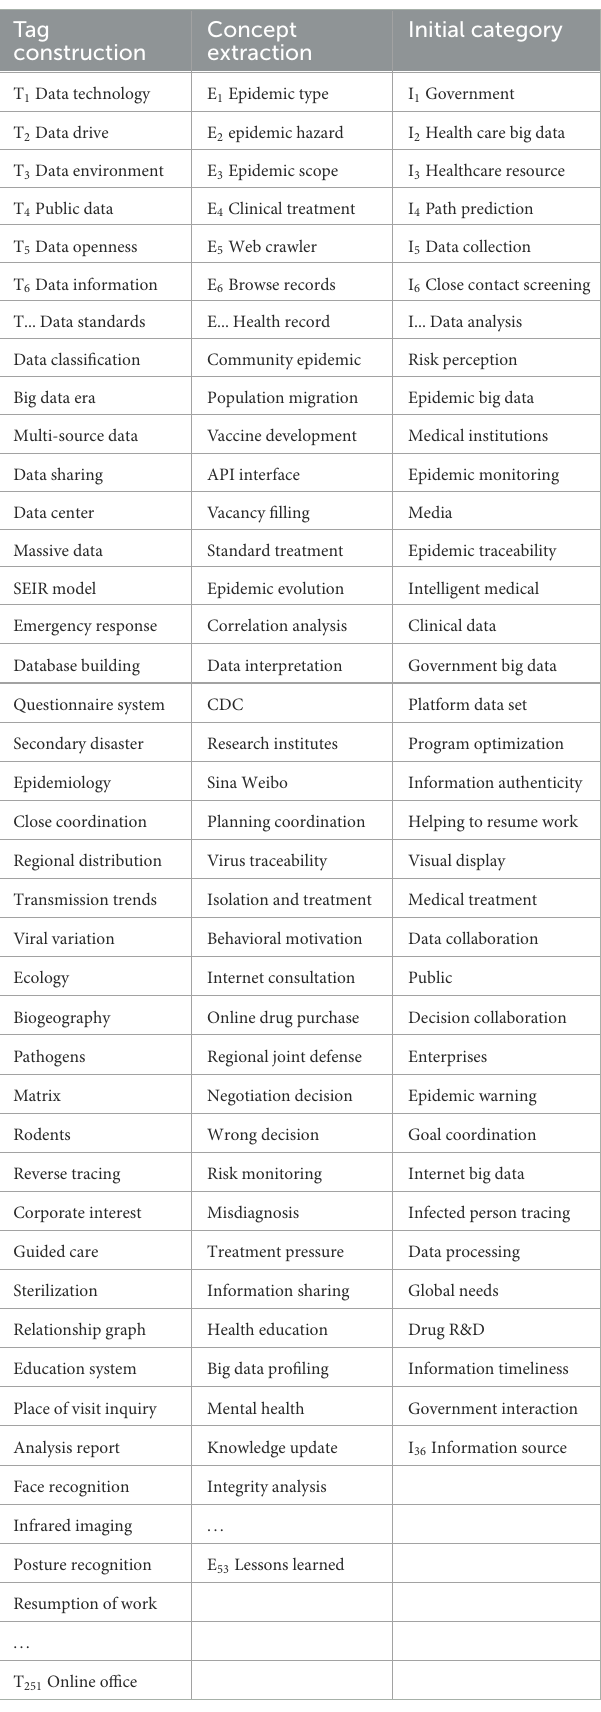
TABLE 1 Open coding preliminary